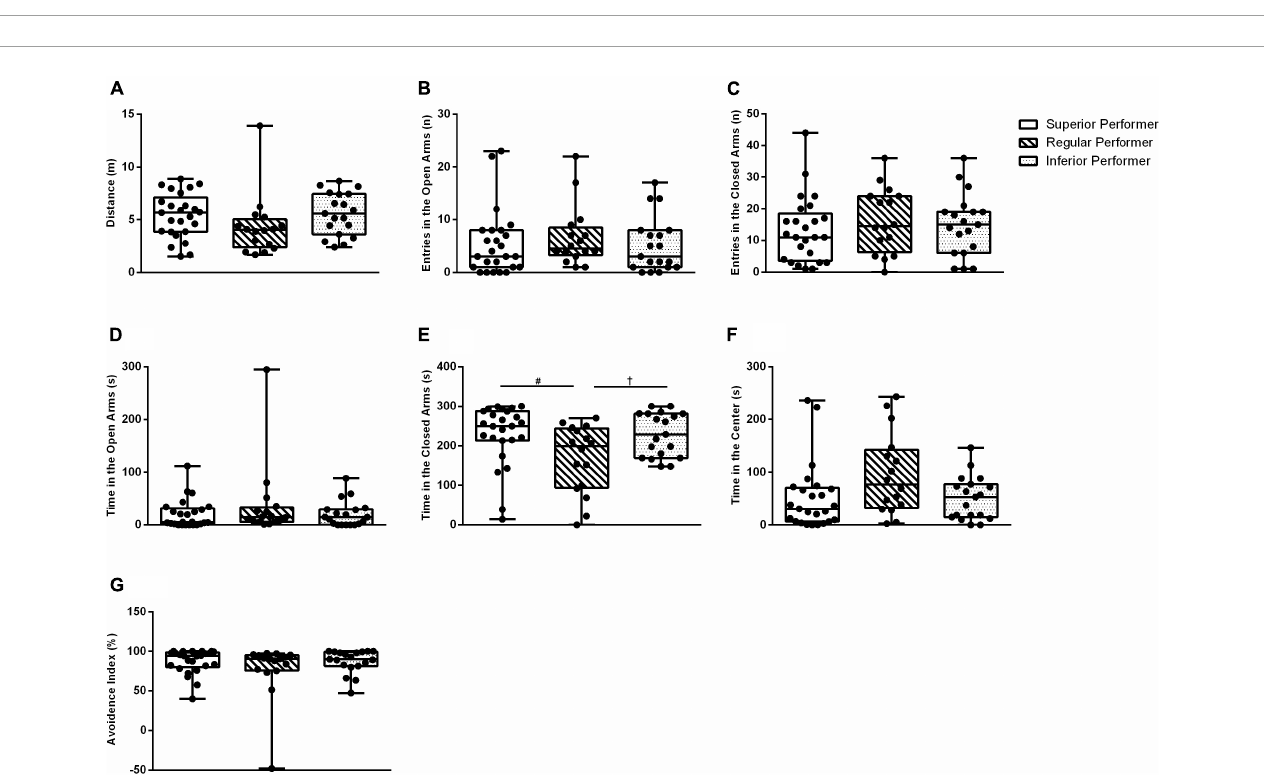
FIGURE2 Anxiety-like behavior in the elevated plus maze test. (A) Distance traveled, (B) number of entries in the open arms, (C) number of entries in the closed arms, (D) time spent in the open arms, (E) time spent in the closed arms, (F) time spent in the center, and (G) avoidance index. Data are expressed in 25–50–75 percentile and range (minimum and maximum). Kruskal–Wallis and Mann–Whitney tests were used. # Superior performers vs. regular performers; † regular performers vs. inferior